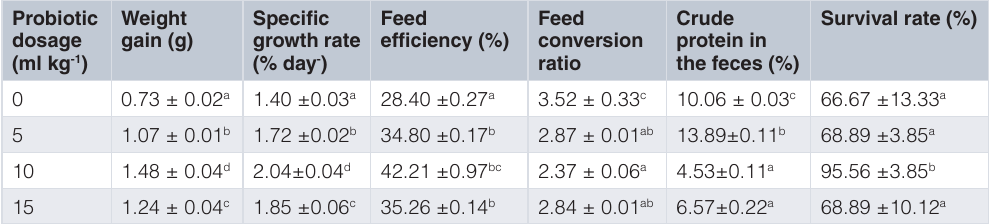
Table 2. Average (±SD) growth performance, survival rate, feed efficiency, feed conversion ratio, and protein in the feces of keureling fish fry ( Tor tambra ) fed for 80 days at different dosage of probiotic. All data were subjected to analysis of variance (ANOVA), followed by the comparison of means using Duncan’s multiple range test. The means at different probiotic dosage across each parameter were compared. When means have the same superscript (a, b, c, d), they are not significantly